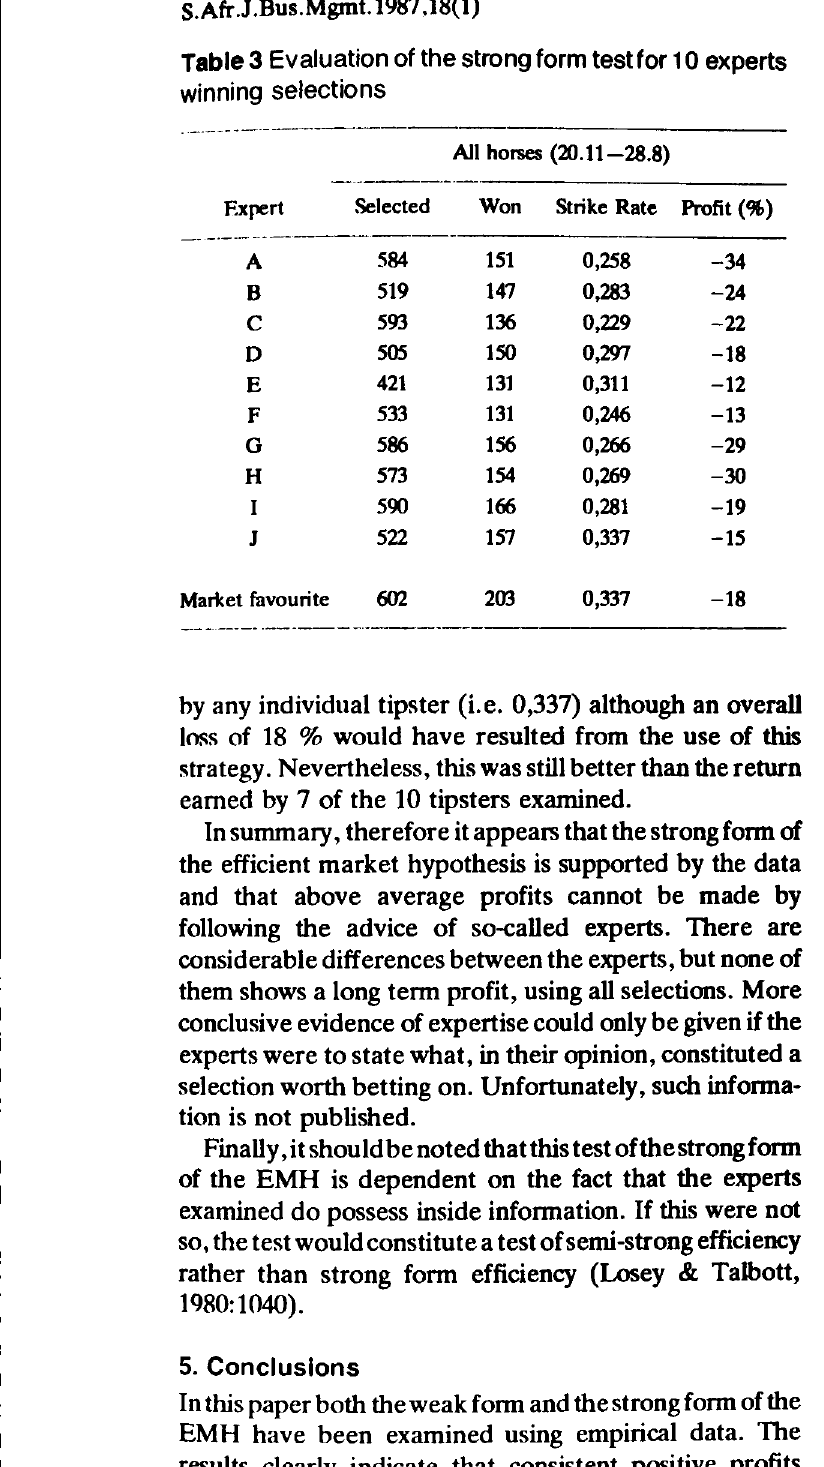
Table 3 Evaluation of the strong form test for 1 o experts winning